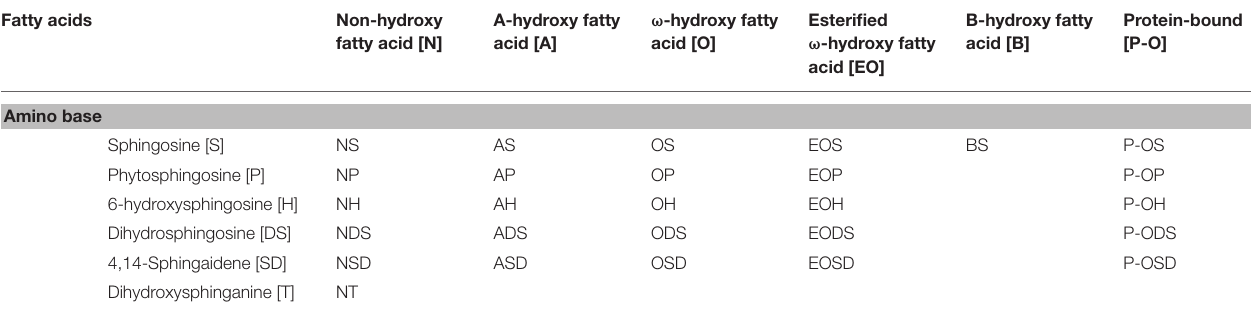
Each ceramide class is represented by a combination of the abbreviations corresponding to its FA and amino base structure (11, 14, 47). [NS], combination of non-hydroxy FA (N) and sphingosine (S); [NP], combination of non-hydroxy FA (N) and phytosphingosine (P); [NH], combination of non-hydroxy FA (N) and 6-hydroxysphingosine (H); [NDS], combination of non- hydroxy FA (N) and dihydrosphingosine (DS); [NSD], combination of non-hydroxy FA (N) and 4,14-sphingaidene (SD); [NT], combination of non-hydroxy FA (N) and dihydroxysphinganine (T); [AS], combination of α -hydroxy FA (A) and sphingosine (S); [AP], combination of α -hydroxy FA (A) and phytoshingosine (P); [AH], combination of α -hydroxy FA (A) and 6-